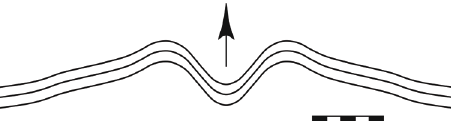
Fig. 44. Lituites toernquisti Holm, 1891 from the Upper Grey Orthoceratite Limestone; lirae in specimen units = 1